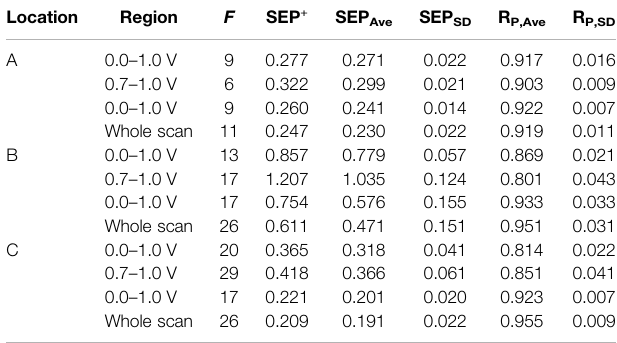
TABLE 1 | Parameters and prediction results of the optimal PLS voltammetric region model for soil SSEAC data. Location Region F SEP + SEP Ave SEP SD R P,Ave